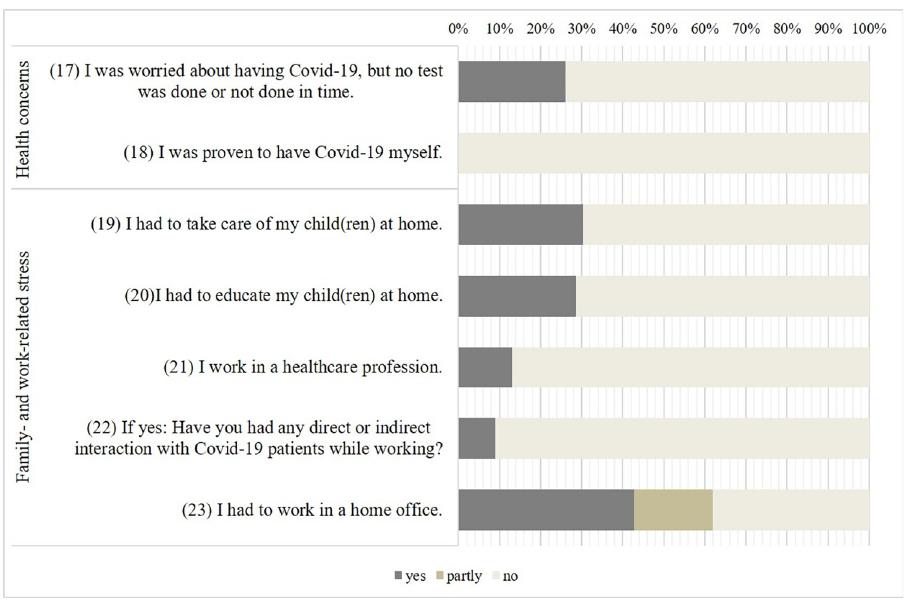
Fig 4. Questions about the relevance of stressors related to the pandemic. Percentages of participants answering yes or partly.